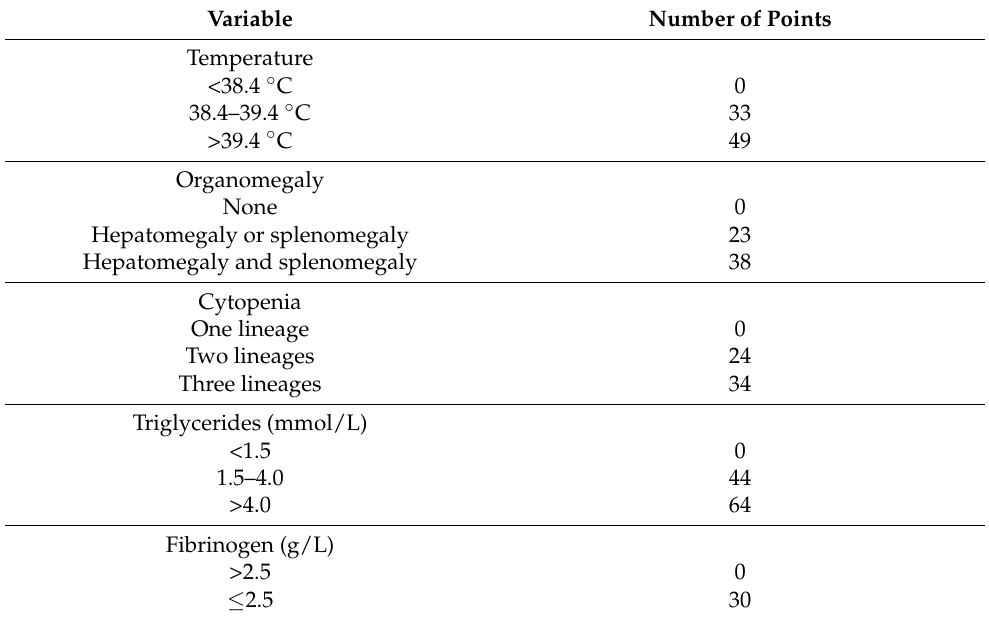
Table 4. HScore † ‡ for diagnosis of haemophagocytic lymphohistiocytosis